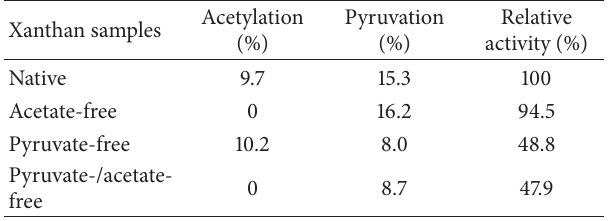
Table 3: Influence of the various xanthan on activities of xanthan lyase produced by Microbacterium sp.